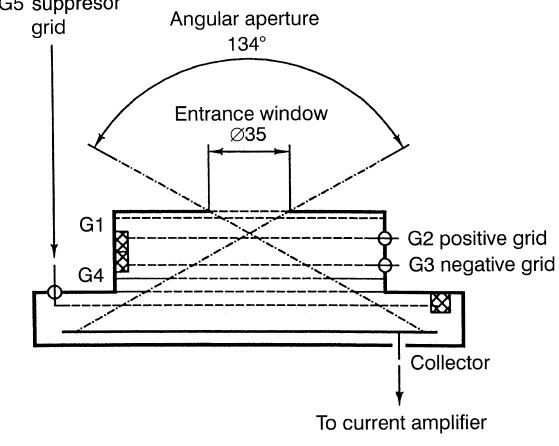
Fig. 1. Schematic of the sensor